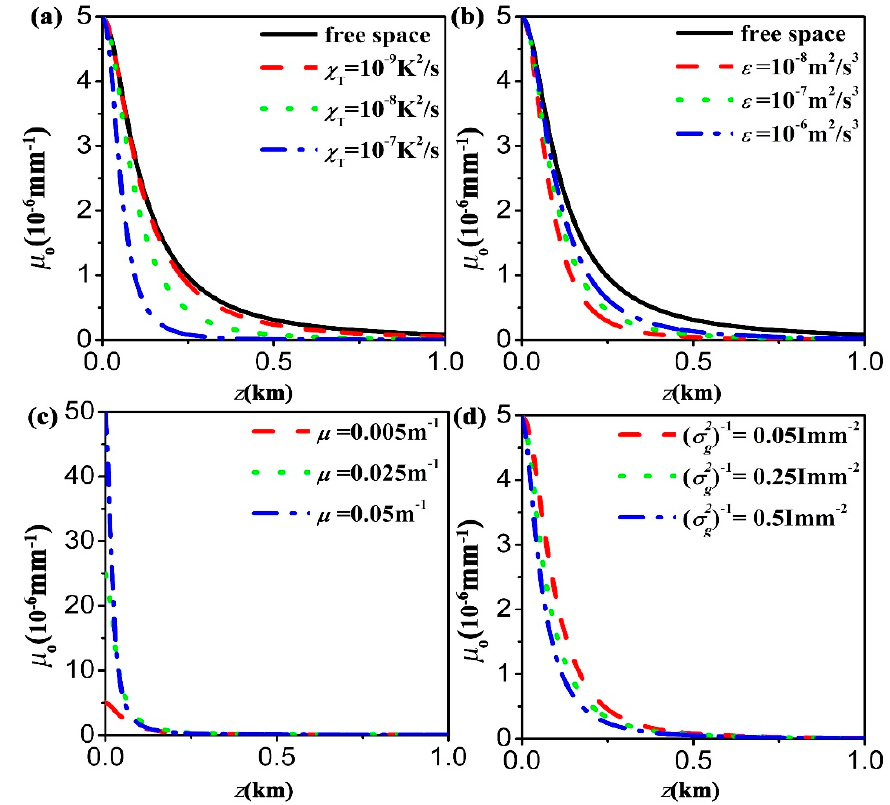
Figure 6. Variation of µ o via the propagation distances z in oceanic turbulence. ( a ) for di ff erent values of χ T ; ( b ) for di ff erent values of ε ; ( c ) for di ff erent values of the initial twist factors; ( d ) for di ff erent values of coherence width.